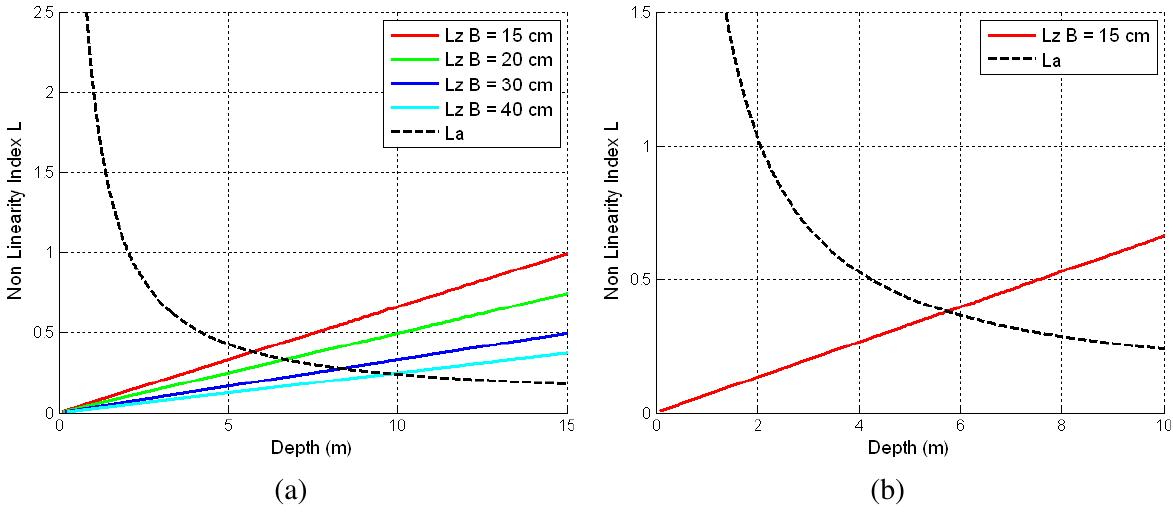
Figure 4. Depth and angular non-linearity indexes witch focal length f image size 320 £ 240 . (a) Different stereo rig baselines (b) A zoomed version for our stereo rig configuration B = 15 cm.